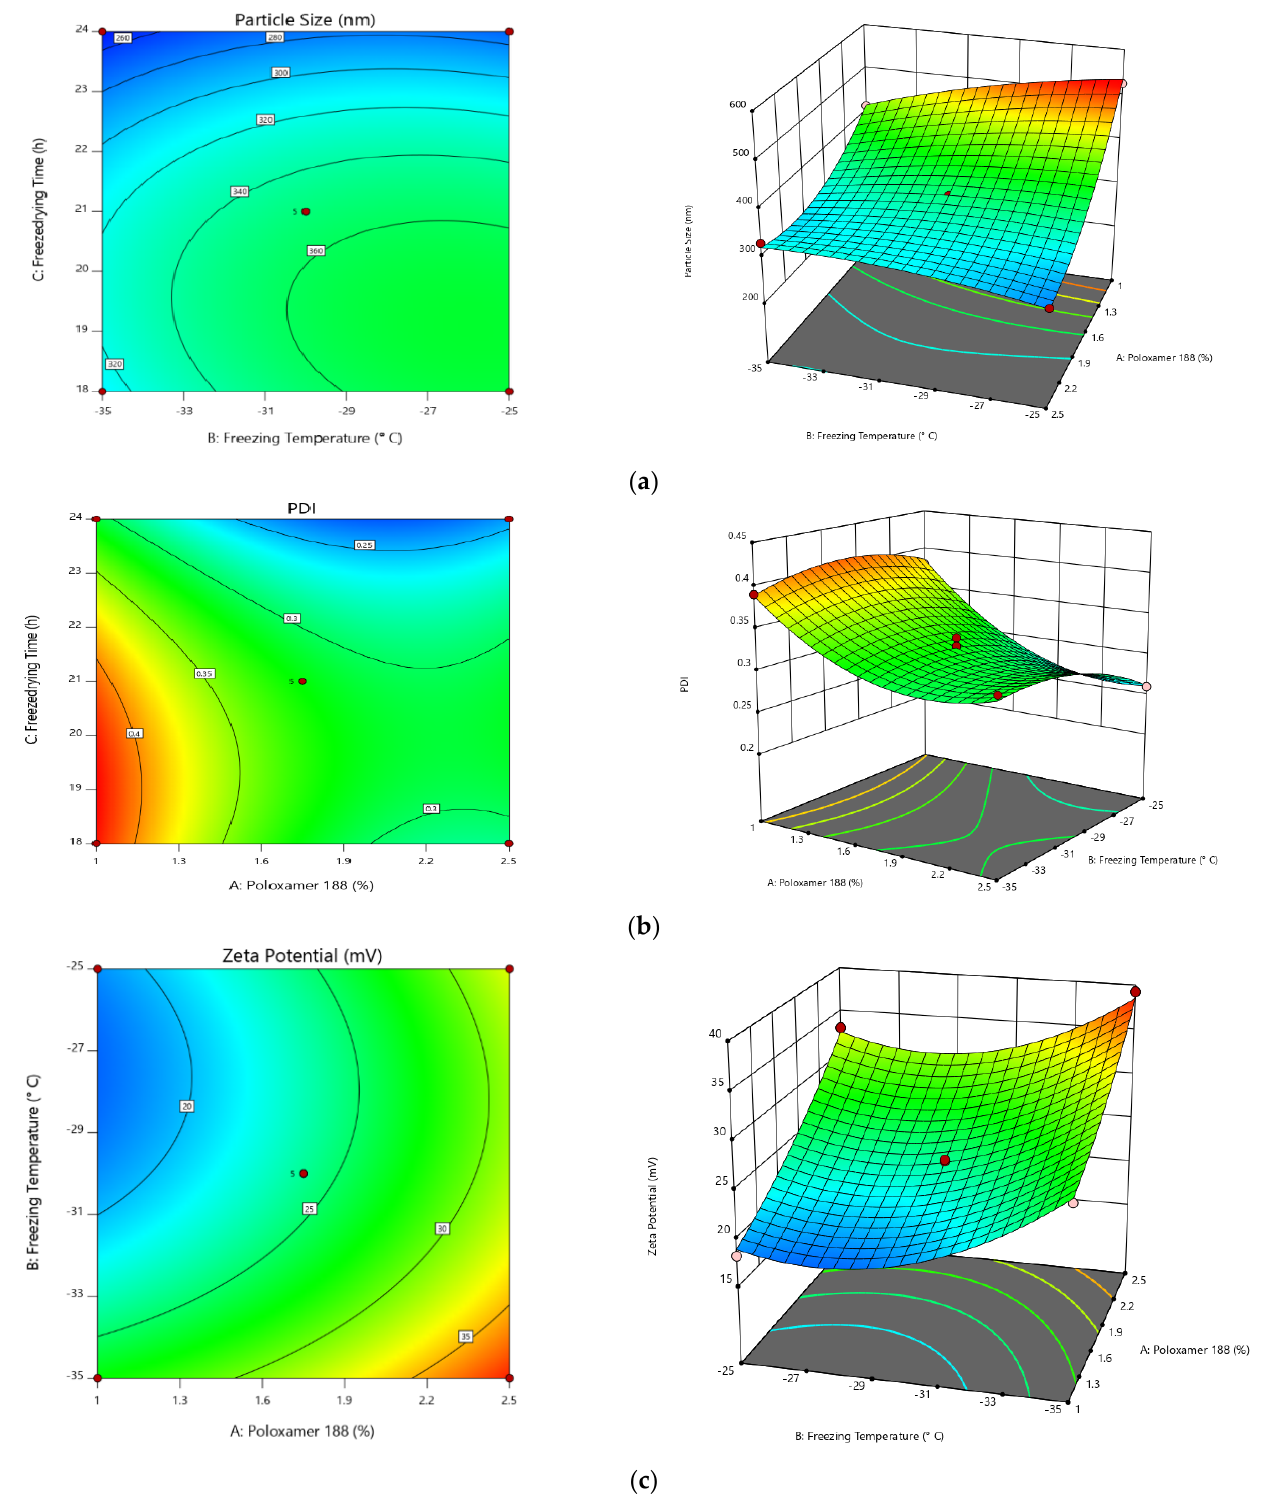
Figure 4. RSG for ( a ) PS, ( b ) PDI, and ( c ) zeta potential.